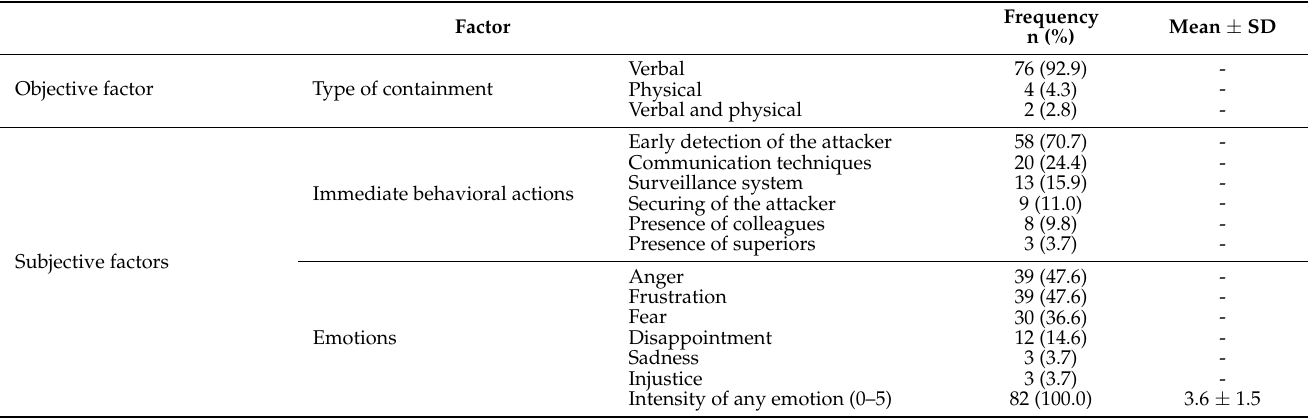
Table 3. Factor analysis of WV management by the assaulted